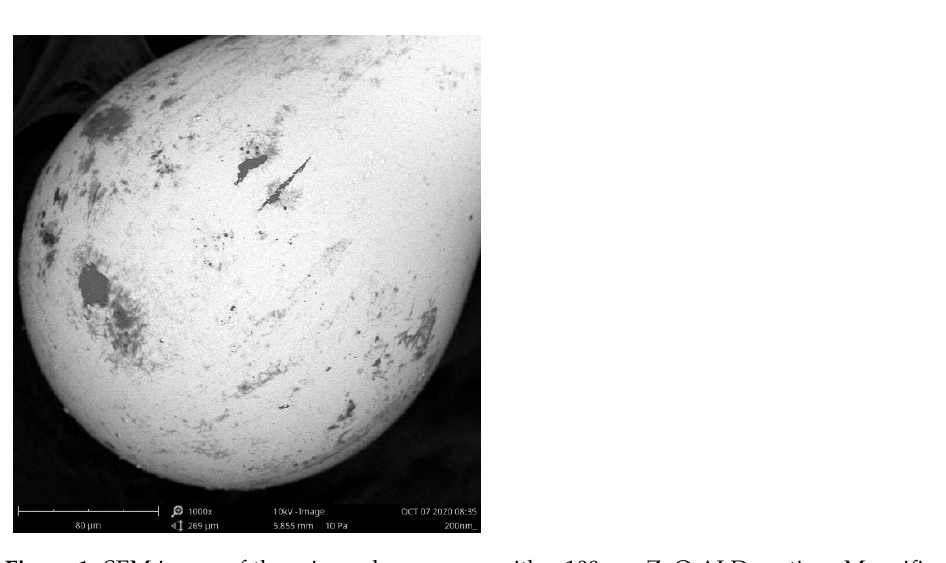
Figure 1. SEM image of the microsphere sensor with a 100 nm ZnO ALD coating. Magnification of 1000 × .